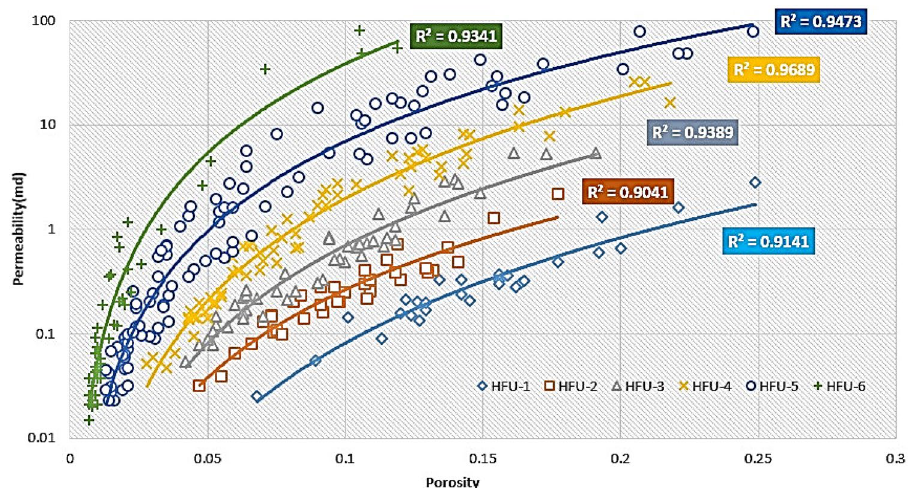
Fig. 15 Porosity–permeability cross-plot based on the obtained HFUs for the Kangan field